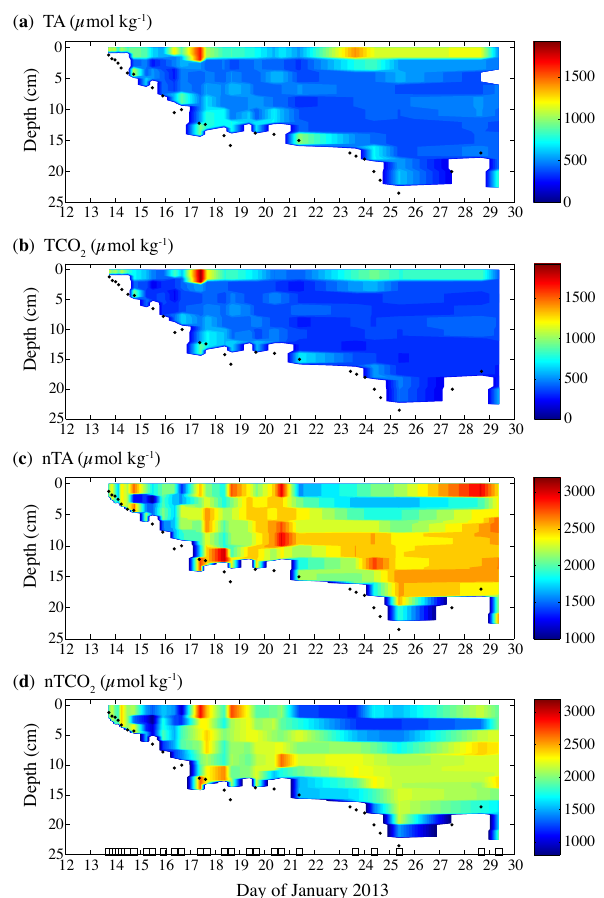
Figure 4. Evolution of (a) TA (ice) (µmolkg − 1 ), (b) TCO 2(ice) (µmolkg − 1 ), (c) nTA (ice) (µmolkg − 1 ) and (d) nTCO 2(ice) (µmolkg − 1 ). Sea ice thickness is illustrated by black dots. Open squares in the lower part of (d) mark the sampling times.